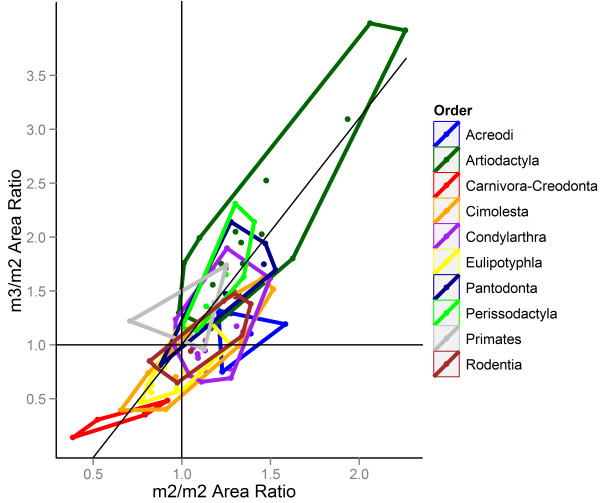
Minimum area polygons for the ten taxonomic groupings. Only groups with more than five genera were included in this analysis. Carnivora and Creodonta have been grouped together as possibly closely-related carnivorous placentals; Primates and Plesiadapiformes are also grouped together. Non-parametric MANOVA results in a highly significant clustering by taxonomic group (p<0.001), even when removing the most extreme members of Artiodactyla. The only group to overlap with the range of the carnivorous placental grouping is Cimolesta. “Condylarths” and Acreodi are clustered together in an area distinct from that occupied by Artiodactyla and Perissodactyla, with only three “condylarths” overlapping in range with the extant ungulate groups, showing that “archaic” and extant ungulates possess clearly distinct tooth morphologies.